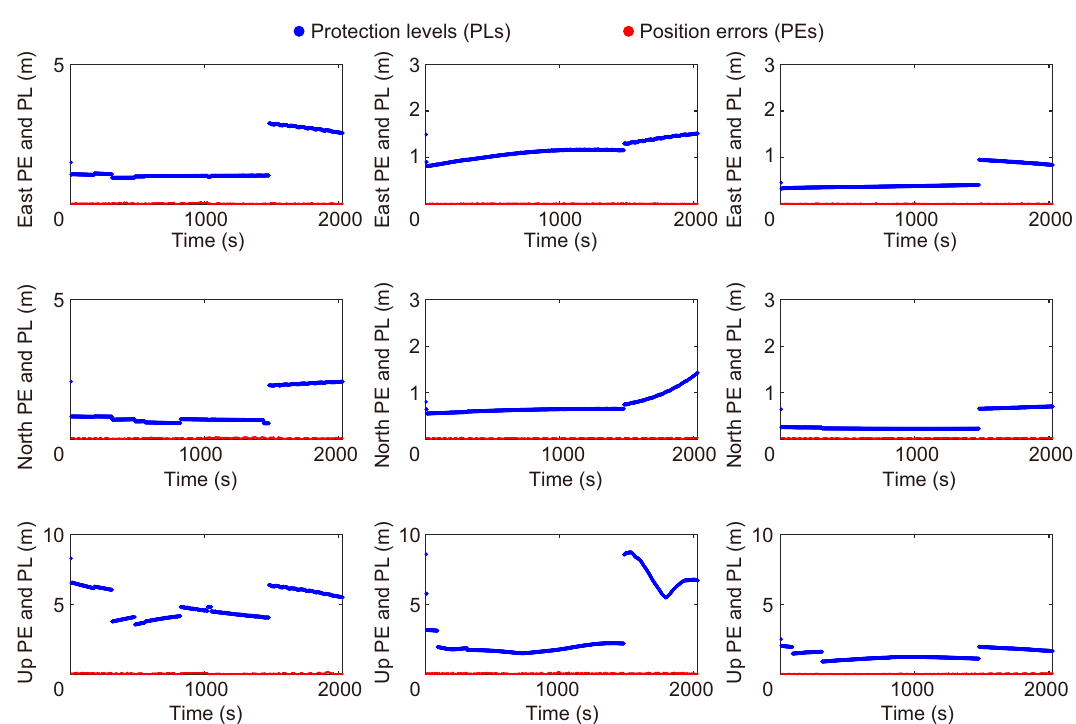
Fig. 8 Performance of the first kinematic dataset for PPP-WAR model with regional atmospheric corrections (left), PPP-AR model (middle), and PPP-RTK model